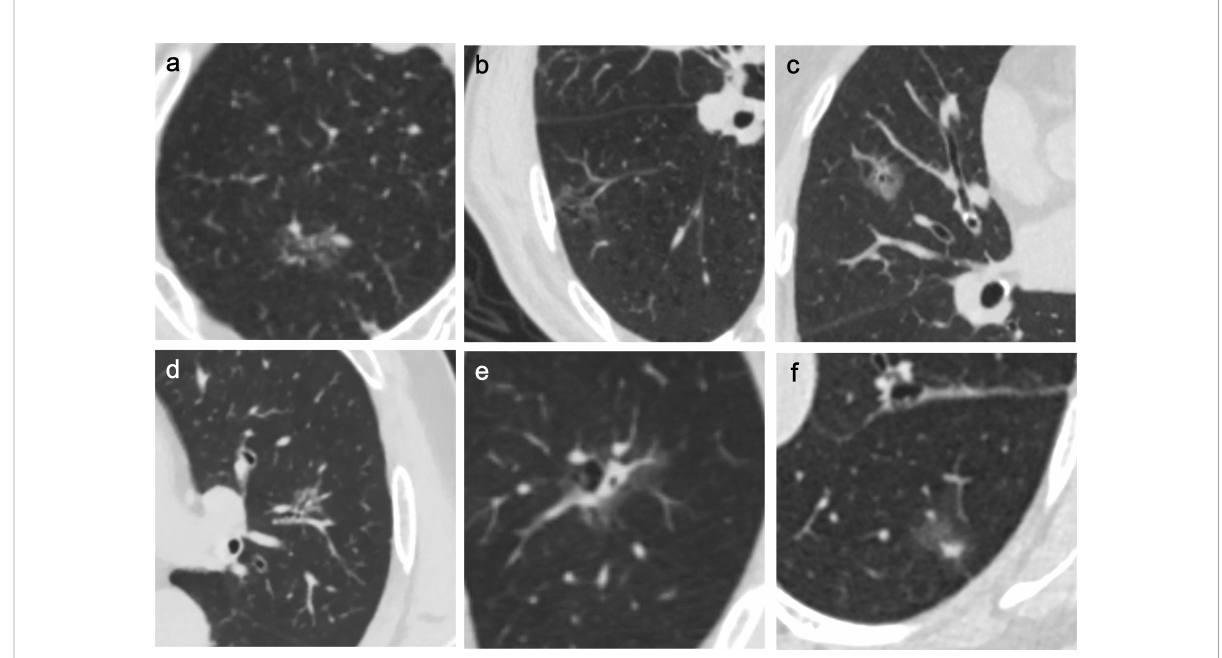
FIGURE 2 Independent risk factors for SSN growth in CT non-quantitative factor analysis. The six imaging features mentioned in the article are as follows: (A) lobulated sign, (B) vacuole sign, (C) vascular sign, (D) air bronchogram, (E) vacuole sign in PSN, (F) size of the solid component in the